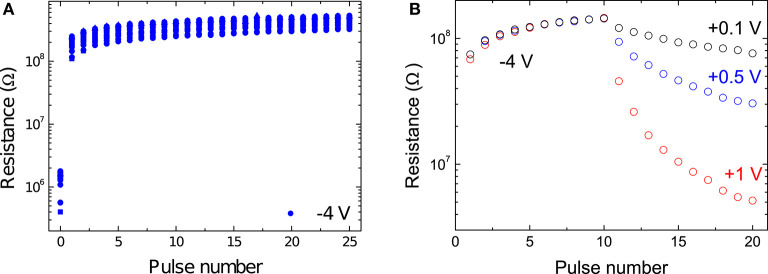
(A) Device response to the application of multiple RESET pulses of −4 V. Supplementary Figure 1 shows the results for varying RESET amplitudes. (B) Device response to the application of multiple SET pulses of varying amplitudes of +0.1 V (black), +0.5 V (blue), and +1 V (red). 10 RESET pulses of −4 V are applied to increase the resistance before the application of the potentiation pulses.